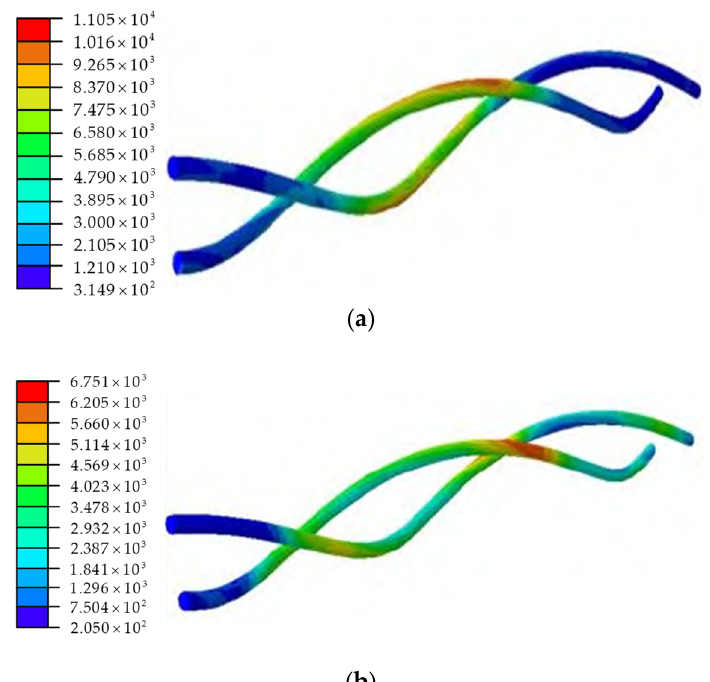
Figure 8. Stress distribution cloud of optical cell [41]. ( a ) Stress distribution cloud when the fiber is twisted clockwise; ( b ) Stress distribution cloud diagram when the fiber is twisted counterclockwise.